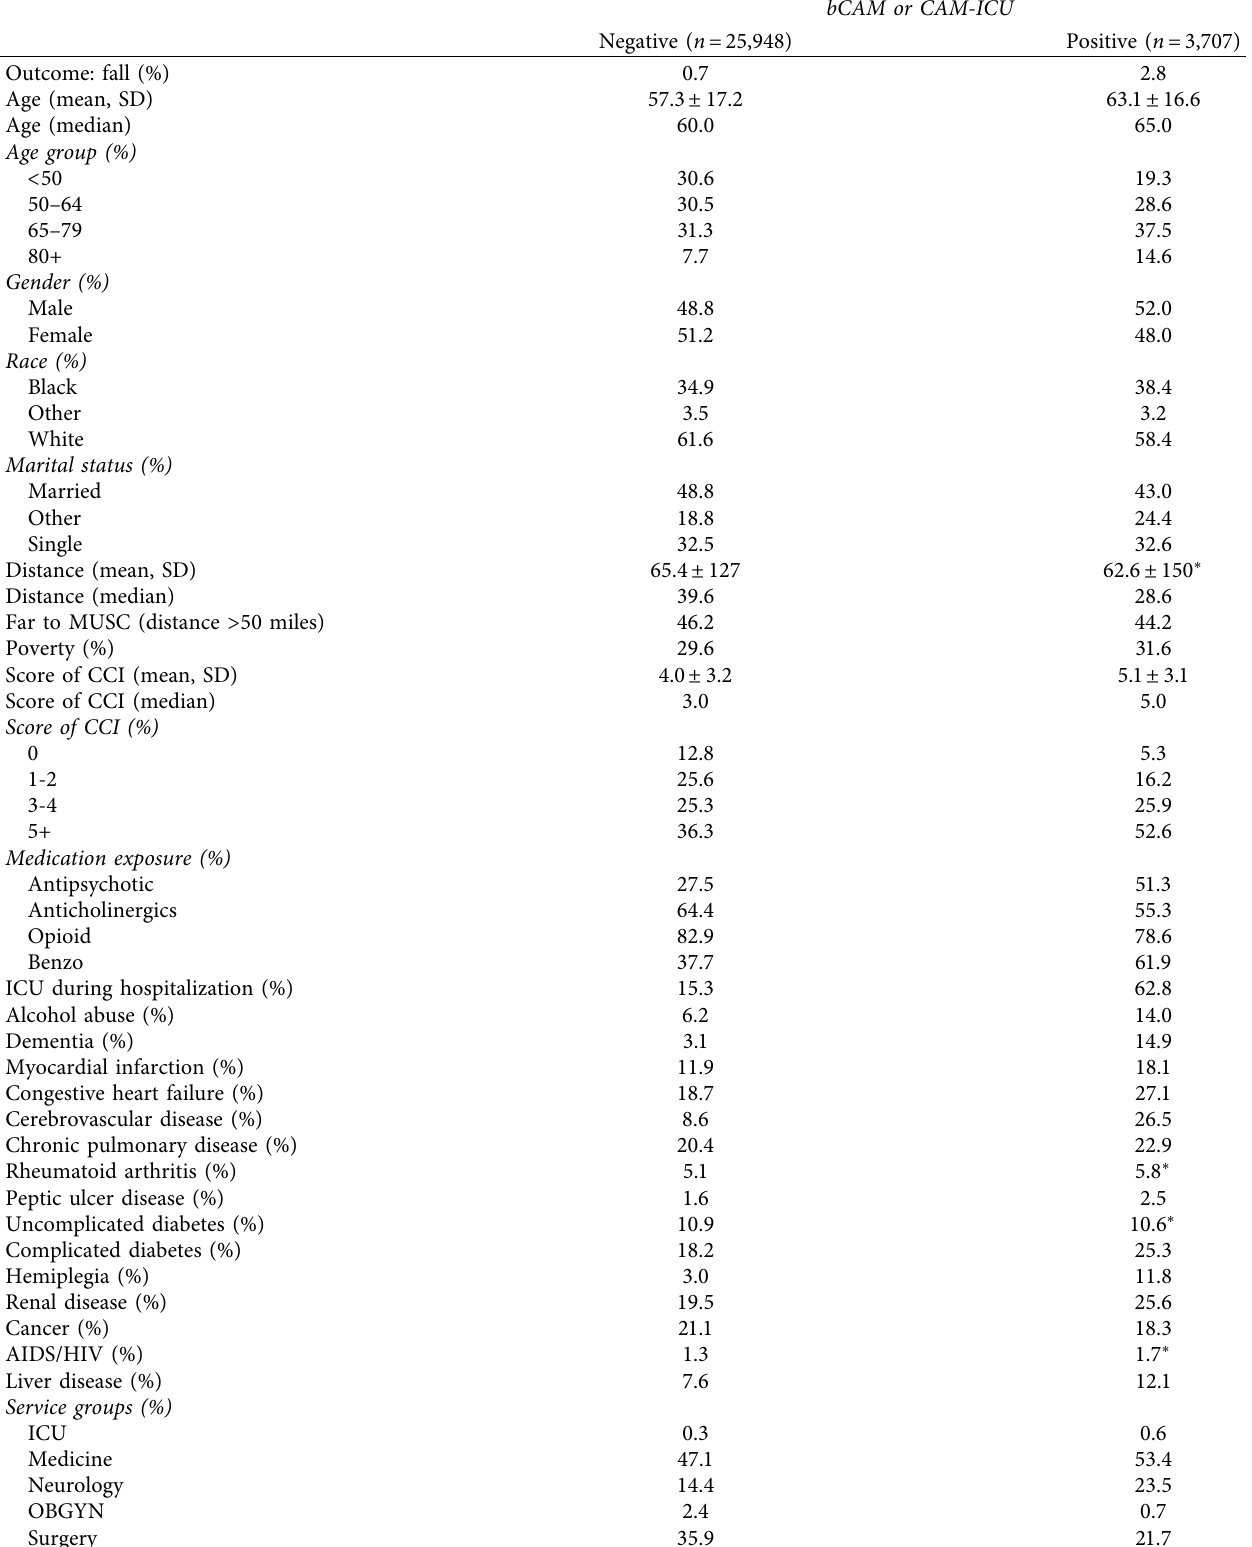
Table 1: Demographics of delirious and nondelirious